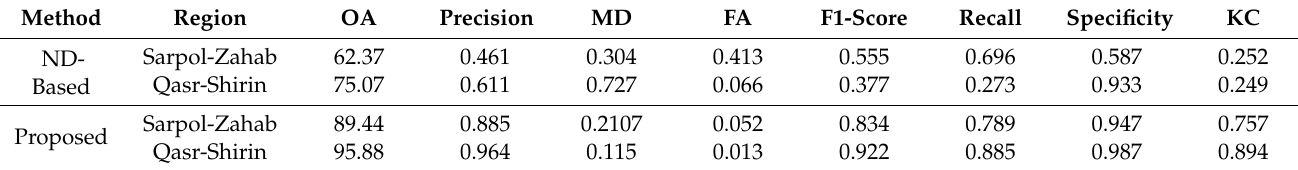
Table 5. The numerical results for the built-up area detection on two datasets.